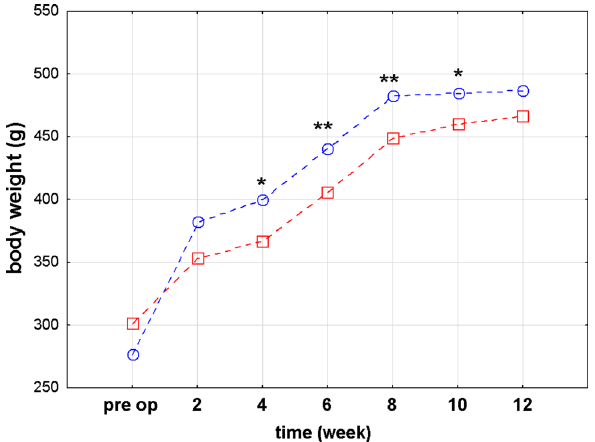
Figure 1. Comparison of body weight (g) of Zucker (Crl:ZUC(ORL)-Lepr fa ) rats before surgery and every two weeks after ileal transposition (IT) or control (SHAM) surgery. For readers convenience, the points are connected with dashed lines and additionally significance level for p < 0.05 was marked as * and p < 0.01 as **,